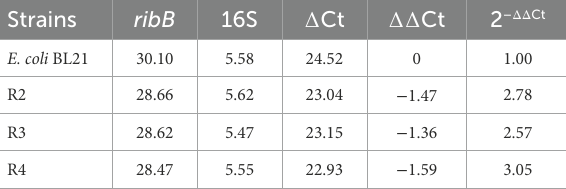
TABLE 4 RibB gene transcript level assays of different strains by qPCR.